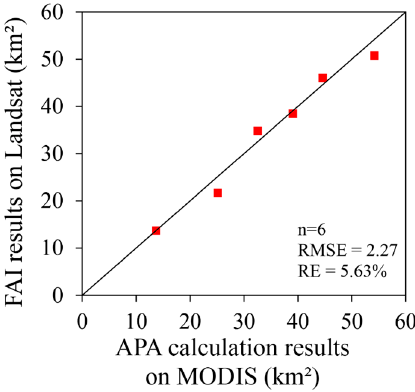
Figure 4. Comparison between the APA results on MODIS and the corresponding six–floating algae index (FAI) results on TM/ETM+ images of algal blooms.